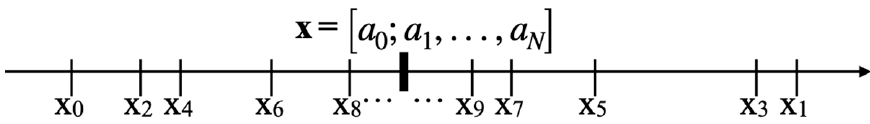
Figure 4. Nesting of the value of a continued fraction by its convergents.